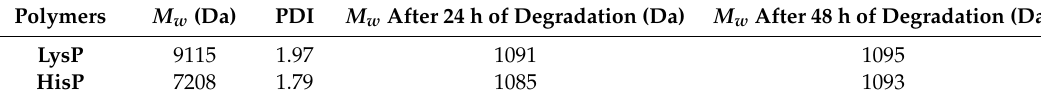
Table 1. Molecular weight of polymers and their